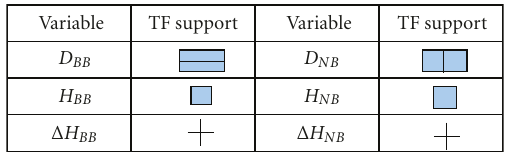
is shown in Figure 3. To compare directional (cid:13) H changes, the (cid:13) H estimation was carried out pairwise; entropies were estimated along a time axis at a mean frequency and along a frequency axis at a mean time so that the respective pair had a common reference point centered in the TF